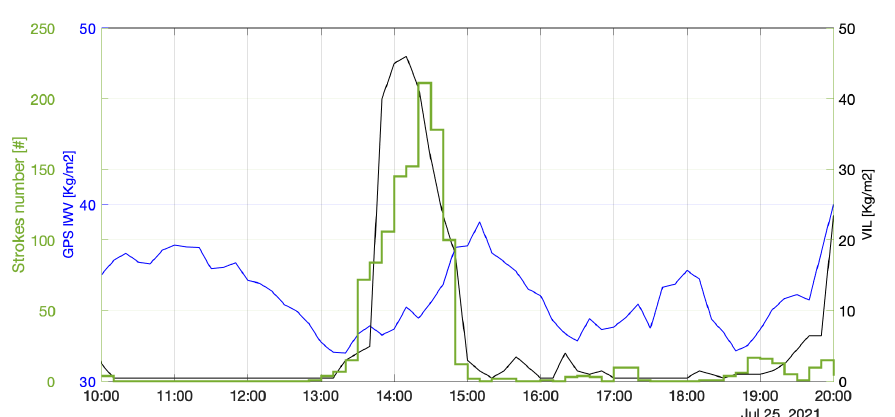
Figure 10. The picture shows a comparison between the VIL-radar parameter (black line), obtained by calculating the median over an area with a radius of about 10 km and centered on Como GNSS receiver, the IWV (blue line) obtained from GNSS observations and the lightning number (green line) also over an area with a radius of about 10 km, centered on Como GNSS